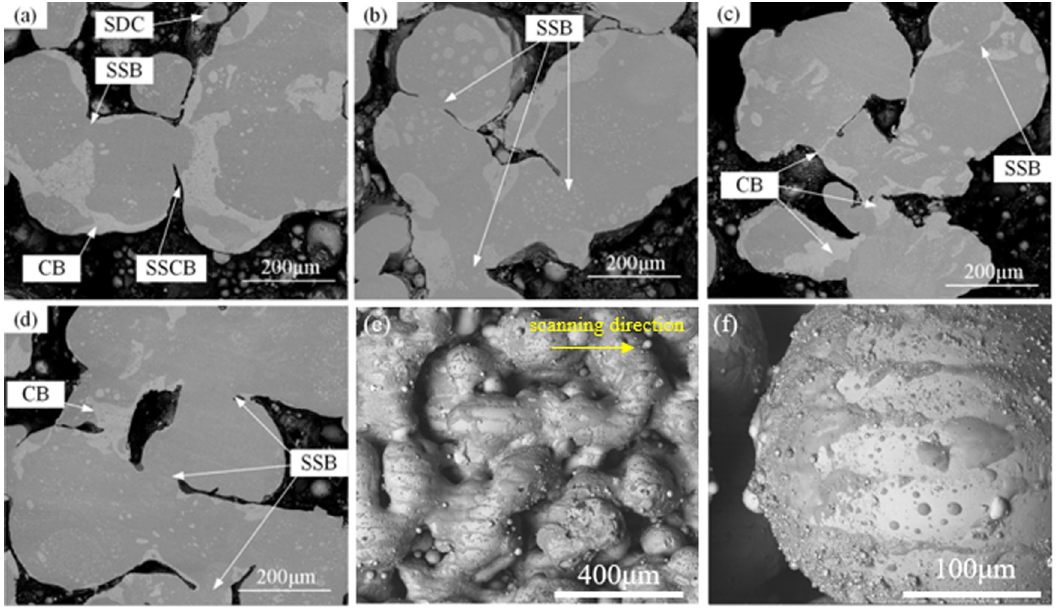
Figure 3: ( a – d ) Cross - section SEM images of the HMS samples showing the morphology after sintering such as SDC, SSB aggregates, CB aggregates, and SSCB. ( e and f ) The morphology of the HMS structure showing a clear Cu - NP melt pattern along the laser scanning